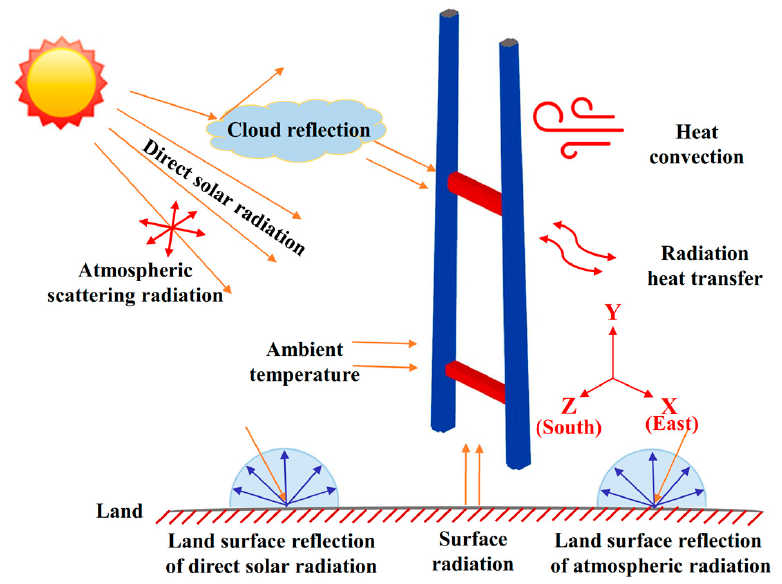
Figure 1. Thermal boundary condition of bridge pylon under sunshine e ff ect.